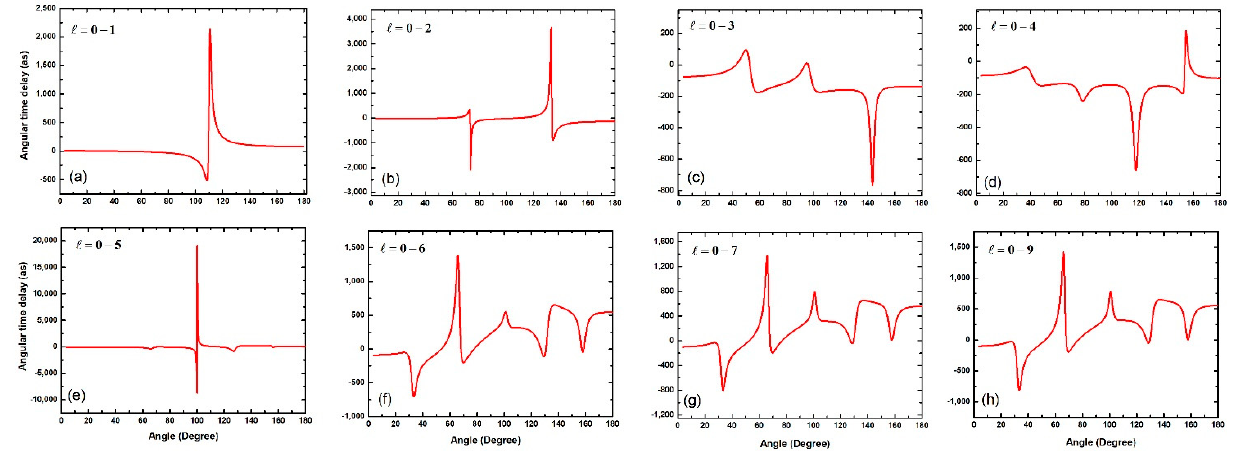
Figure 16. Angular time delay at the energy E 4 = 0.2510 a.u. plotted for different partial wave com- binations ( a ) combinations ( a ) (cid:96) = 0–1, ( b ) (cid:96) = 0–2, ( c ) (cid:96) = 0–3, ( d ) (cid:96) = 0–4, ( e ) (cid:96) = 0–5, ( f ) (cid:96) = 0–6, ( g ) (cid:96) = 0–7 and ( h ) (cid:96) =